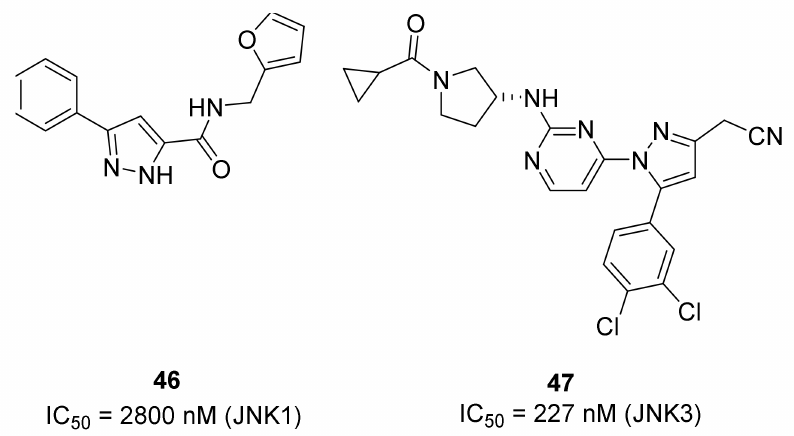
Figure 53. Structures of pyrazole-based JNK inhibitors and their IC 50 values.